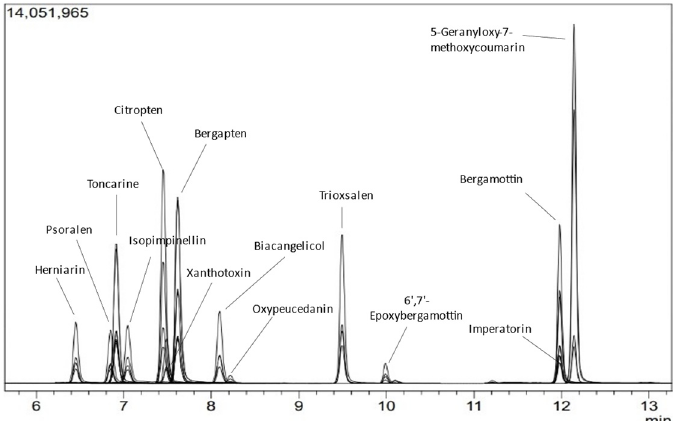
Figure 2. LC-MS/MS chromatogram (MRM acquisition mode) of 14 targeted coumarins using a Shimadzu LCMS8060. Table 1. Linearity of the UPLC-MS Method (Equation and Coefficient of Determination, r 2 ), Limit of Quantitation (LOQ), and Accuracy of the UPLC-MS Method of 14 Coumarins and Furanocoumarins.